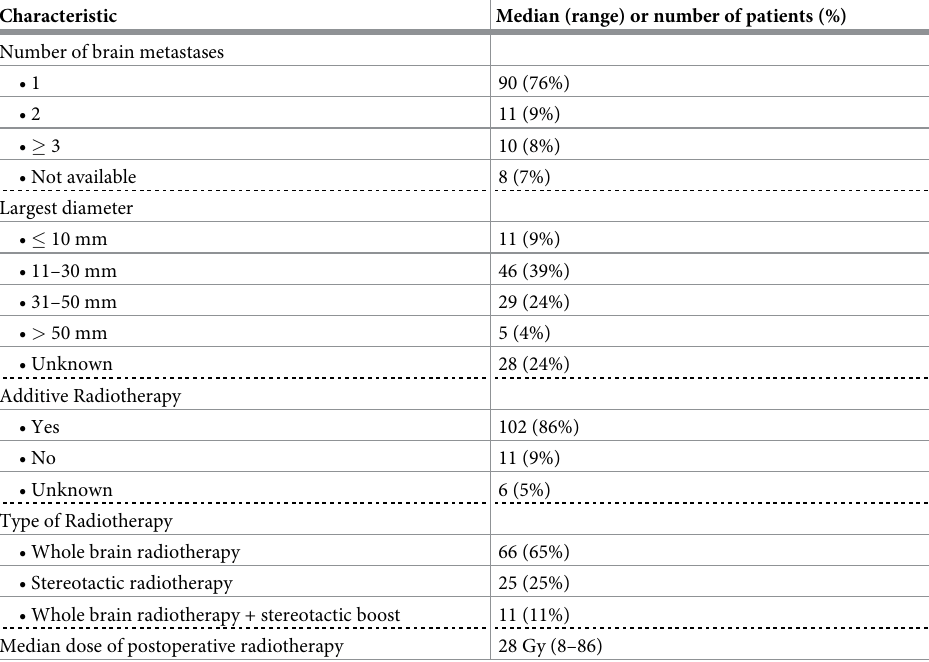
Table 2. Characteristics of brain metastases.